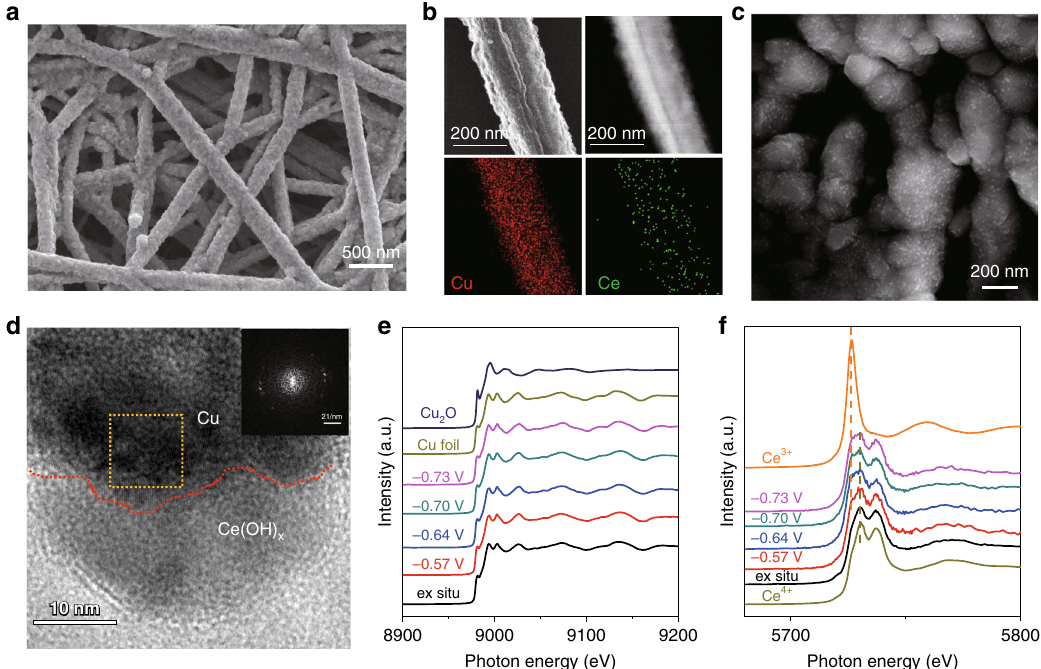
Fig. 2 Structural characterization of Ce(OH) x modi fi ed Cu catalysts. a Scanning electron microscope image, b STEM image and corresponding EDX mapping for Cu and Ce, c High-magnitude SEM image, d High-resolution transmission electron microscopy image of Ce(OH) x /Cu/PTFE. The red dashed line draws attention to the interface, and the inset shows the FFT pattern corresponding to the yellow square. e Operando Cu K-edge and f operando Ce L 3 - edge XAS of Ce(OH) x /Cu/PTFE catalyst under a number of operating potentials in a fl ow